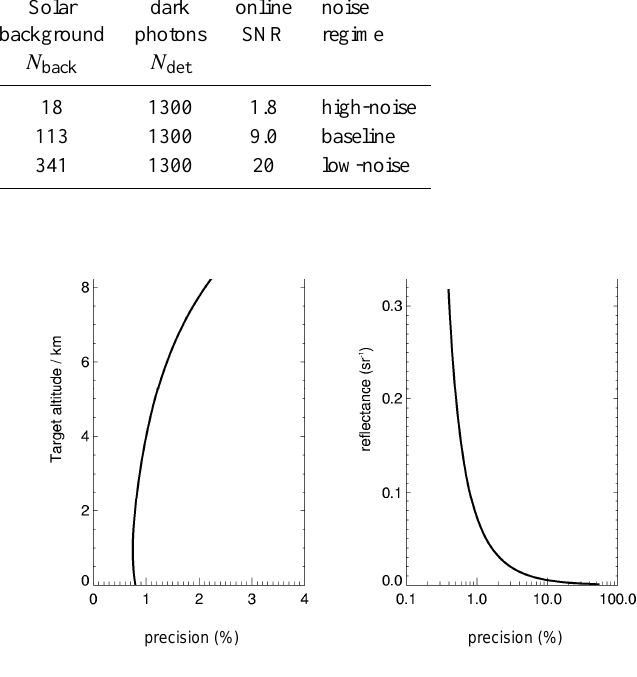
Fig. 6. Methane column measurement precision δX CH 4 / X CH 4 for the MERLIN baseline of Table 2 as function of the scattering sur- face altitude (a.s.l.) (left panel), and as function of the surface re- flectance of a target at sea level (right